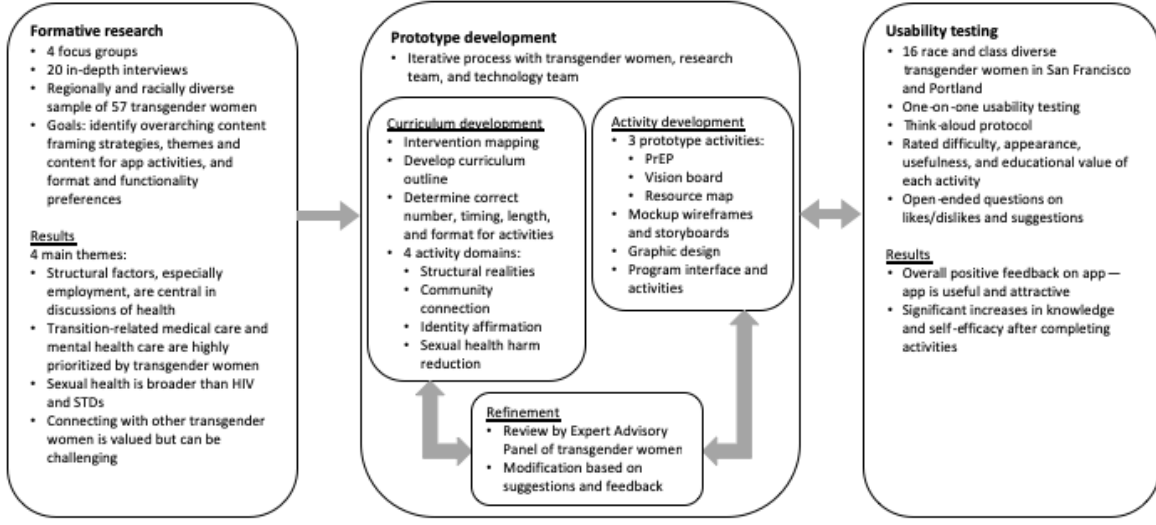
Figure 1. Prototype development process. PrEP: pre-exposure prophylaxis; STD: sexually transmitted